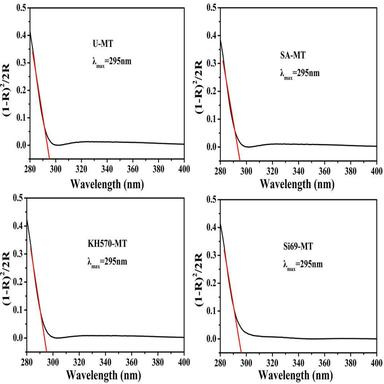
Absorption edges of untreated and modified MT particles measured by the Kubelka-Munk theory.